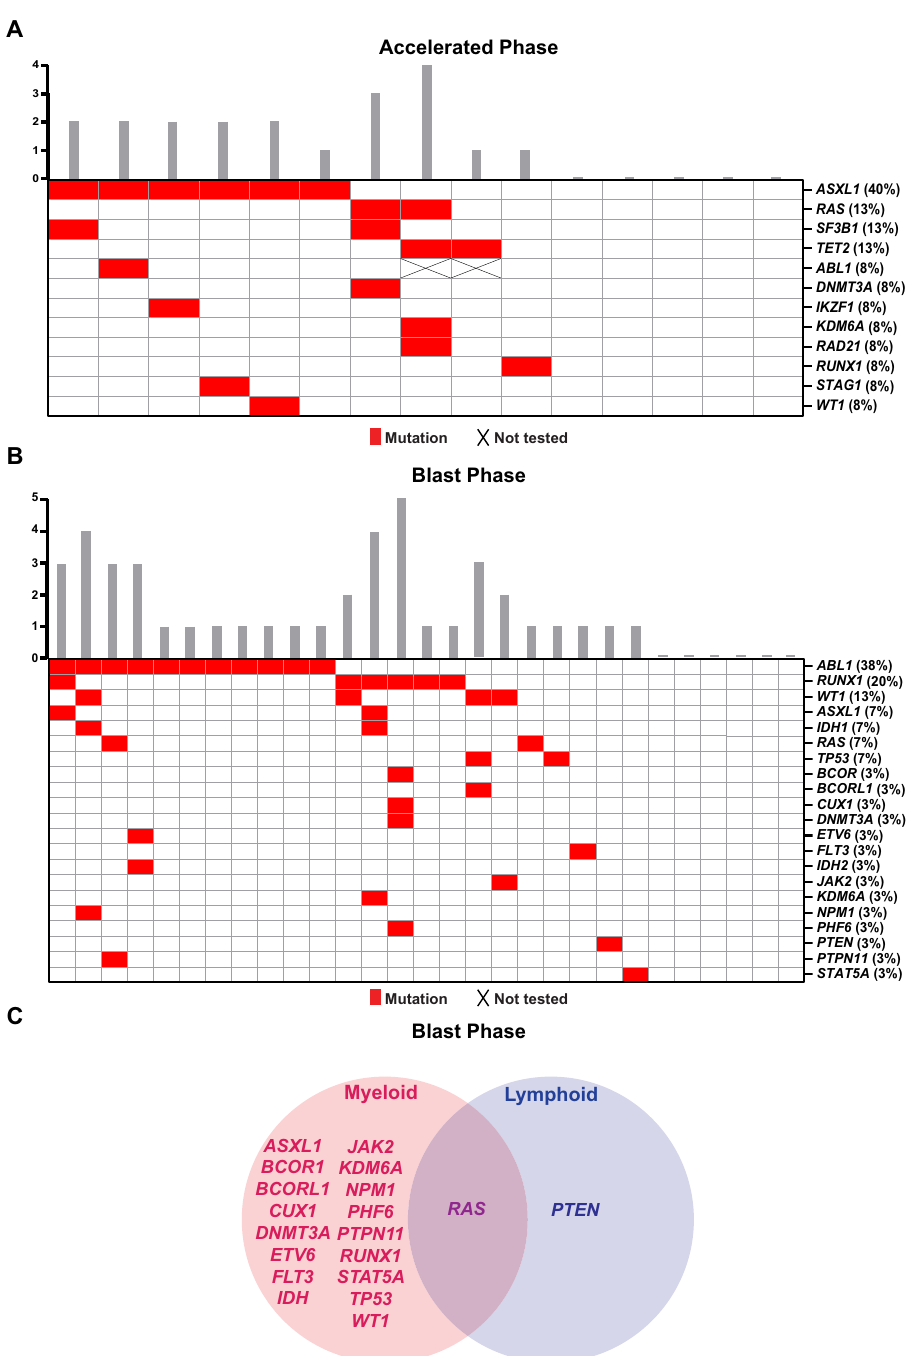
Fig. 3 Mutational pro fi le of accelerated phase (AP-CML) and blast phase (BP-CML) CML. A Distribution of mutations in patients with AP- CML, and B BP-CML. C Association between non- ABL1 gene mutations and the blast phase